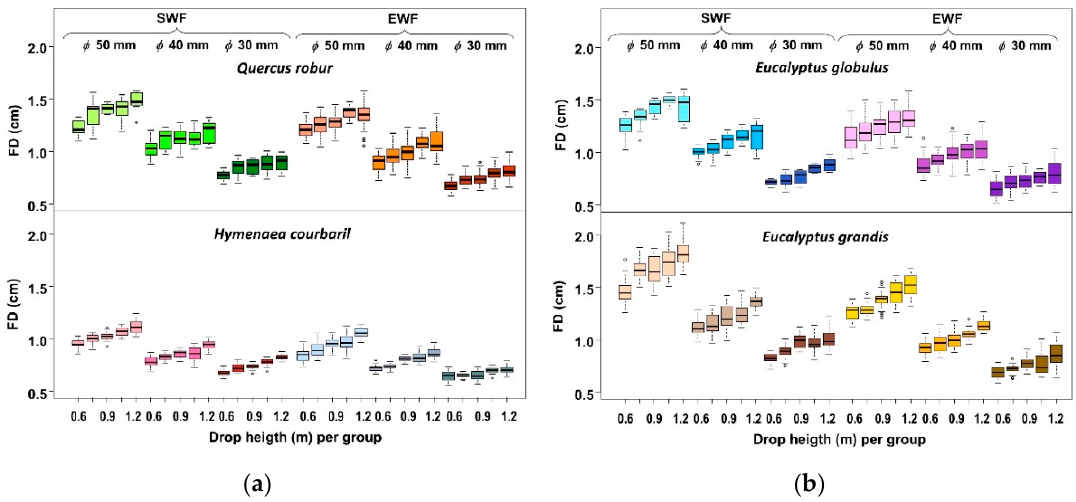
Figure 3. Box plot graphics: footprint diameter (FD) for each wood specie. Different flooring types (solid wood flooring (SWF) and engineered wood flooring (EWF)), drop heights (0.60–0.75–0.90–1.05–1.20 m) and diameter balls (30–40–50mm) were represented. ( a ) traditional hardwood species applied on wood flooring; ( b ) fast-growing hardwoods.